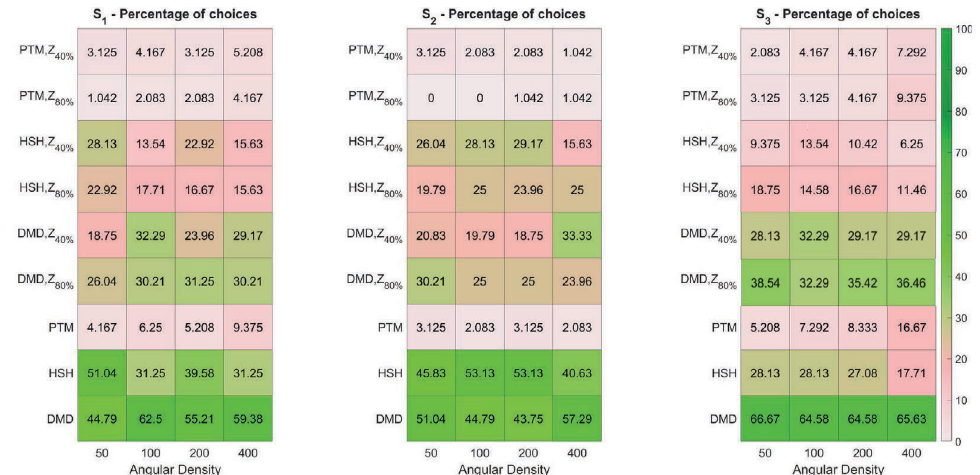
4 on  4 on 4 on 4 on    4 on